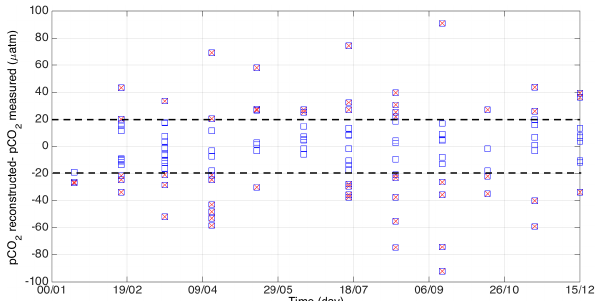
Figure 13. Difference between p CO 2 reconstructed and measured in function of time. The red crosses and black dotted lines represent differences greater than 20µatm. The data represent 10% of the total of data used for the validation data set.